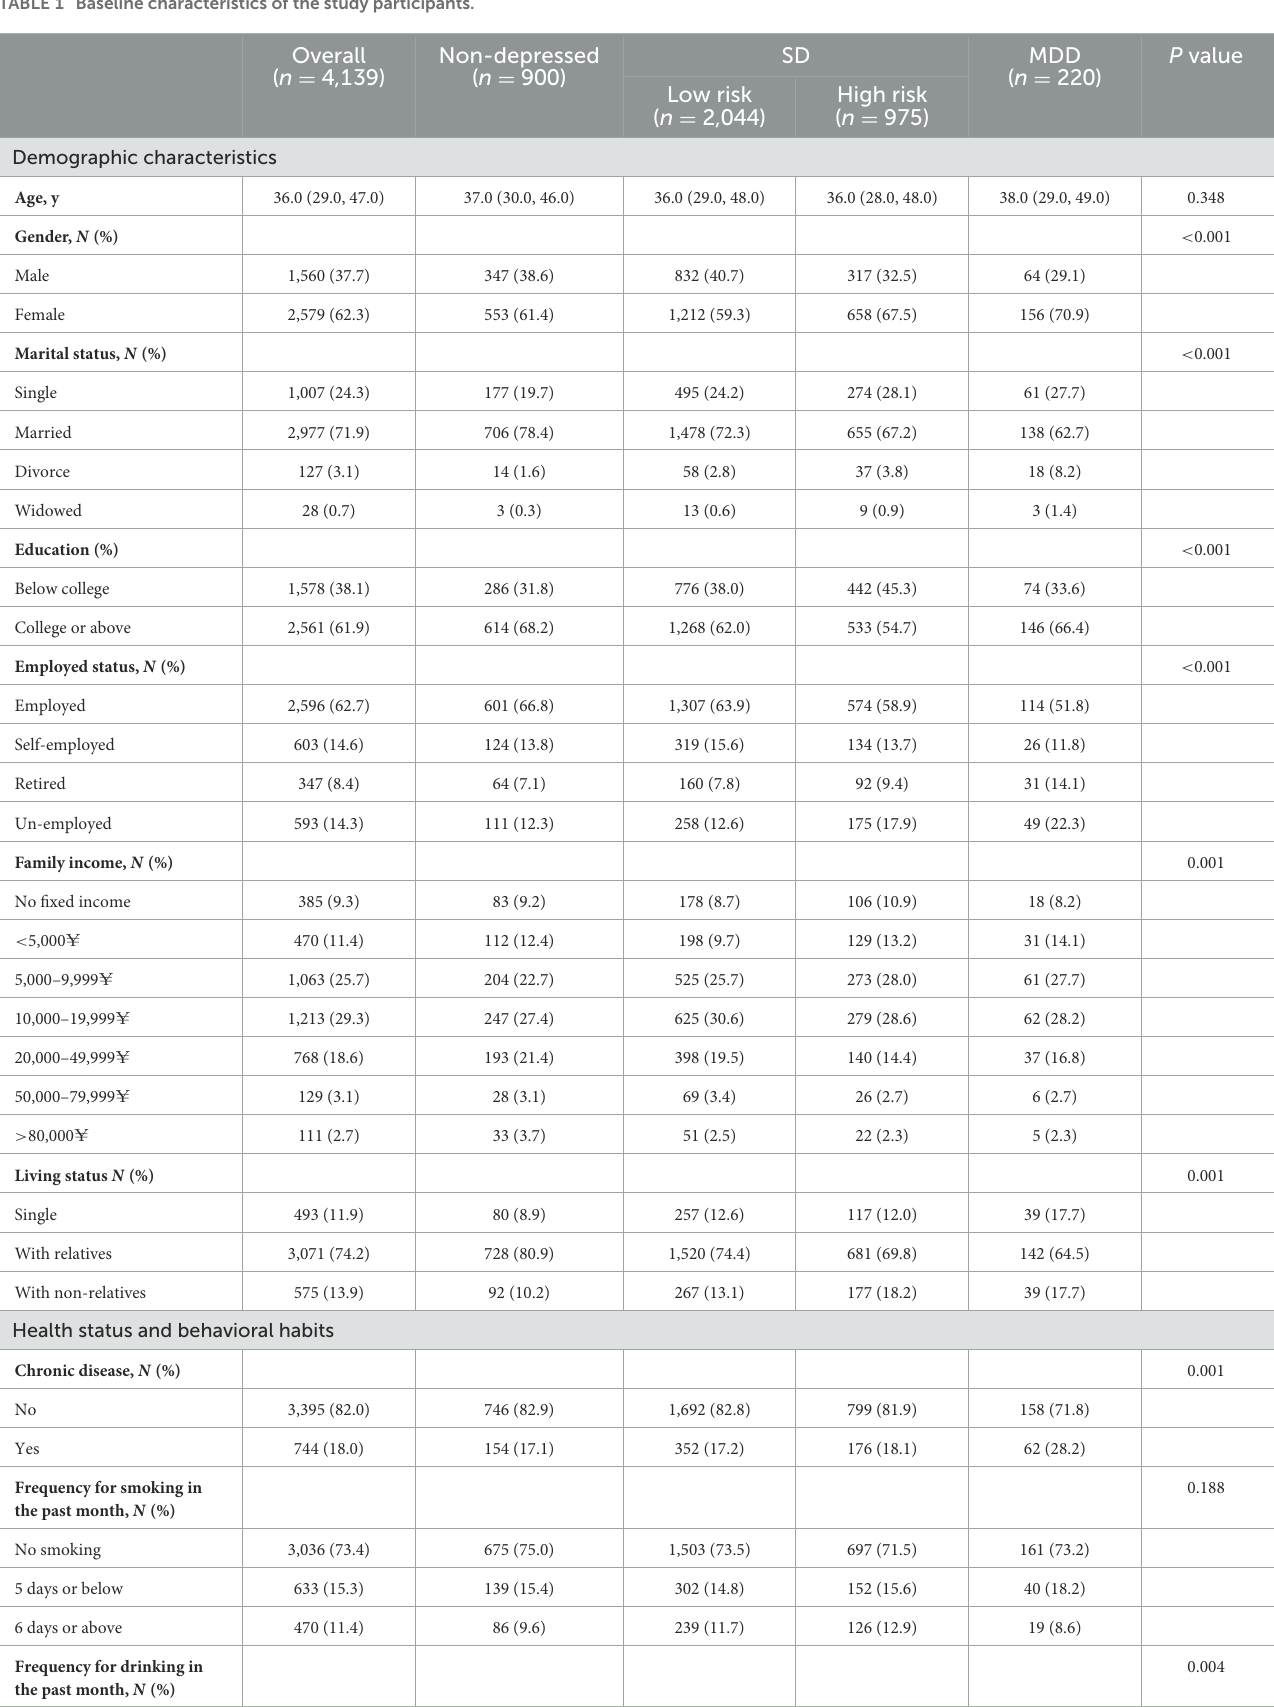
TABLE 1 Baseline characteristics of the study